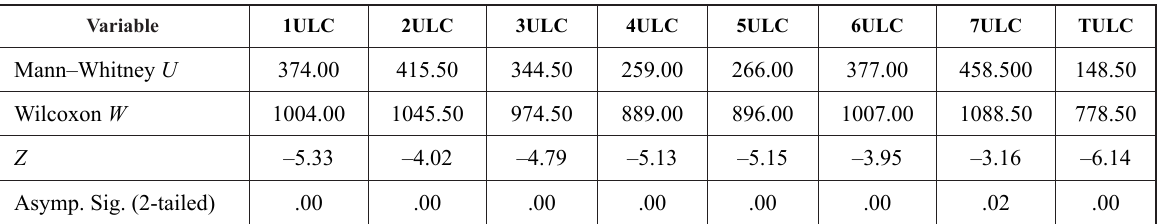
Table 4. The magnitude of the impact of biological growth and development in young children on the examined variables expressed by the Cohen